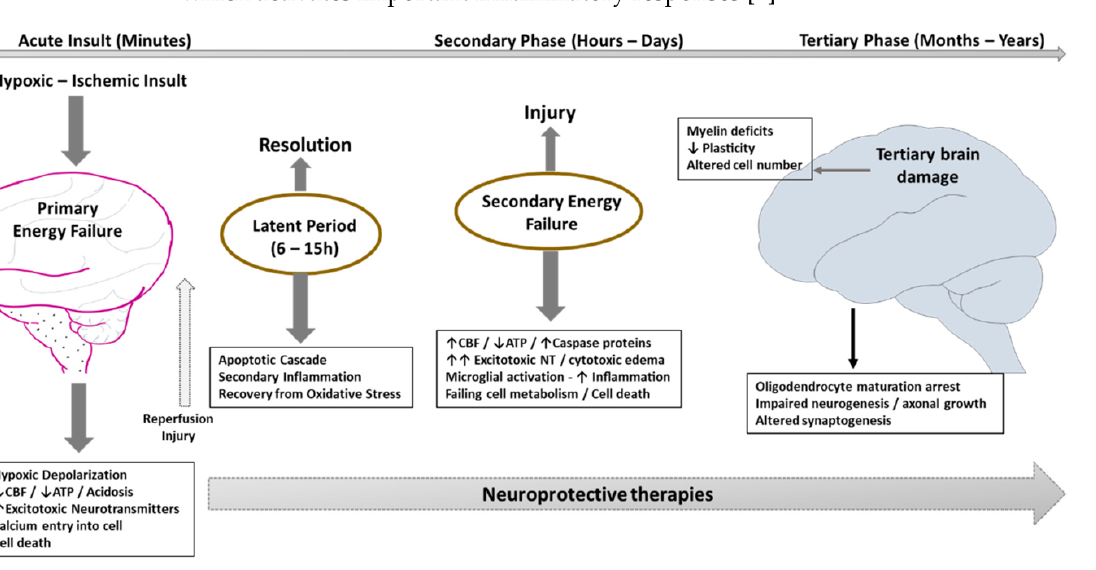
Figure 1. The three phases of development of the pathophysiology of hypoxic – ischemic encephalo- pathy (HIE).